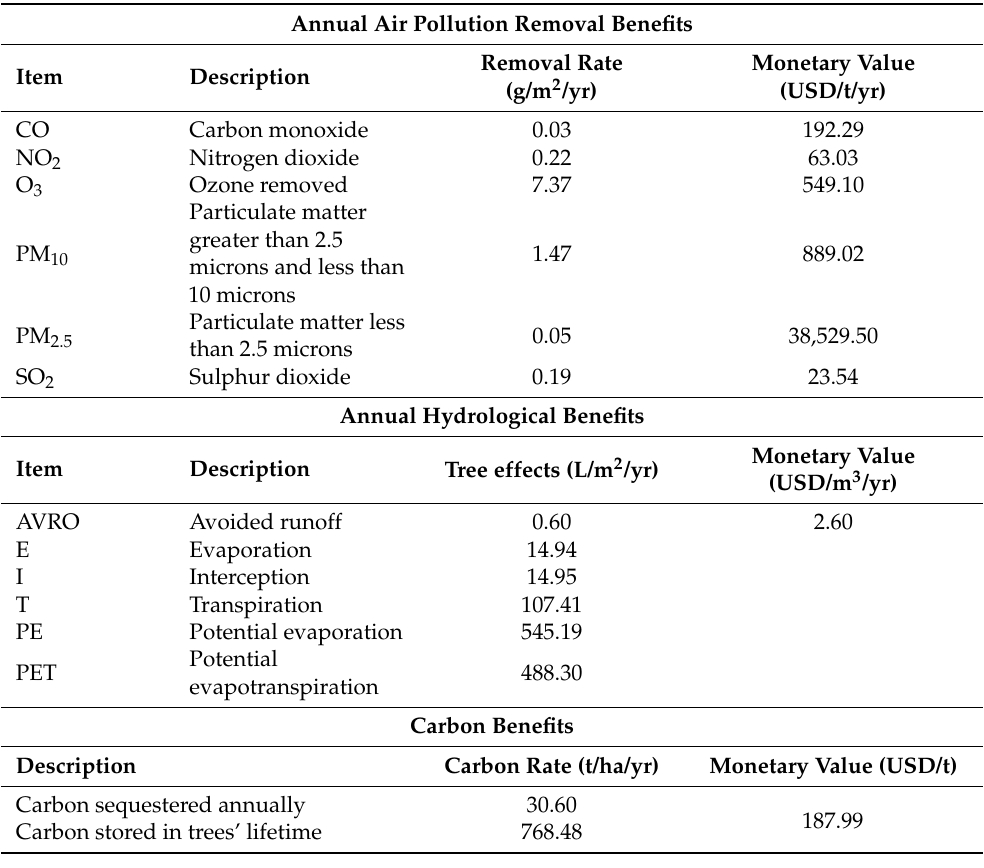
Table 2. Removal rate and monetary value of benefits of tree coverage estimated by i-Tree